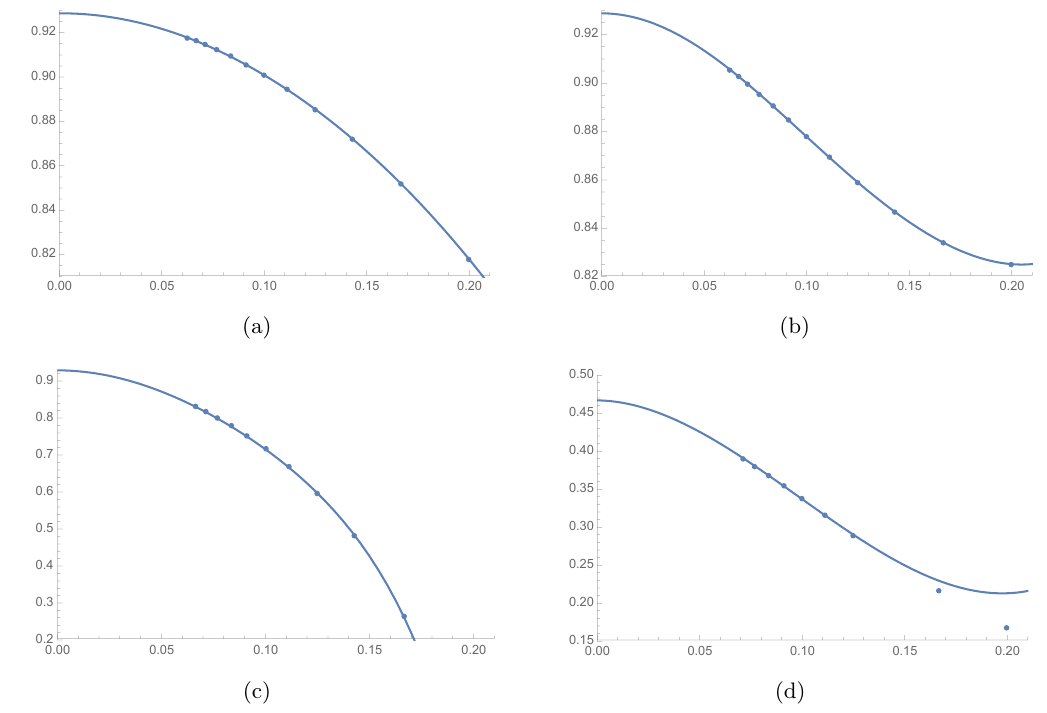
Figure 11 . Same as (cid:12)gure 10, but for a (cid:12)xed distance 2 a = 2 between each pair of operators. The panels are as in (cid:12)gure 10. The extrapolations, shown as blue curves, now uses sizes L of both